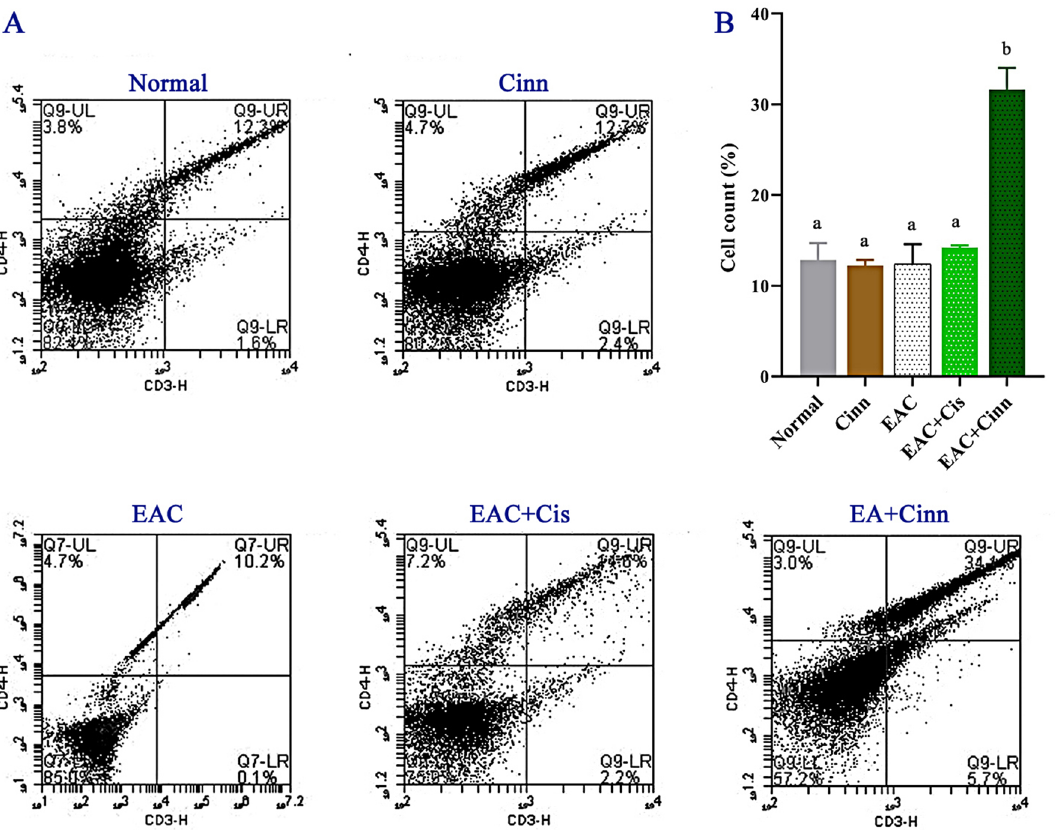
Figure 10. The effect of cinnamon essential oil (Cinn, 50 mg/kg b.wt/day, orally) on the percentage of splenic CD3 + CD4 + cells after 12 days of treatments. ( A ) Representative flow cytometric dot plot analysis (BD Accuri C6 software, version 1.0.23.1, San Jose, CA, USA, www. Accur iCyto meters. com). ( B ) Statistical data were represented as (Mean ± SD), n = 3. Significant differences ( P < 0.05) between groups were shown by different letters. EAC, Ehrlich ascites carcinoma; Cis, Cisplatin (2 mg/kg b.wt,